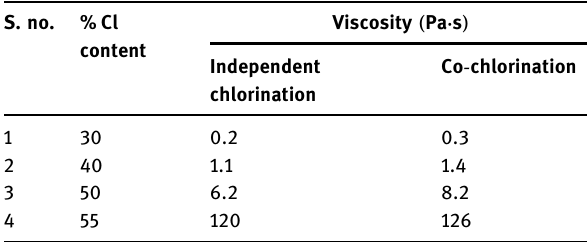
Table 5: Comparison between viscosities of chlorinated para ffi n obtained via independent chlorination and co - chlorination S. no. % Cl